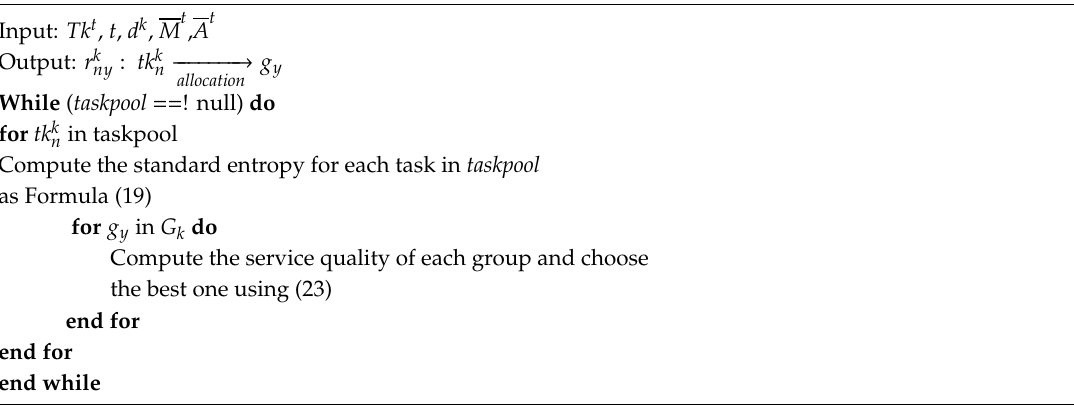
Algorithm 1 Real-time scheduling algorithm based on the information entropy theory